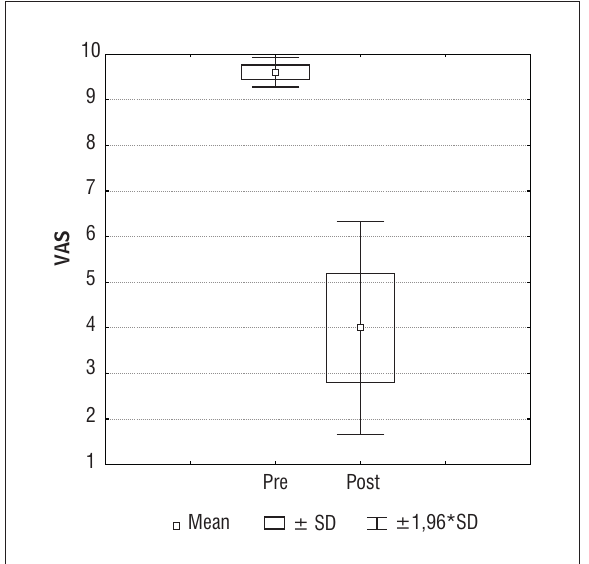
Figure 2 - Measuring of the interference of urinary inconti- nence in daily life using the visual analogue scale (VAS), before and after 16 sessions of endoanal electrostimulation (Student’s paired t-test,